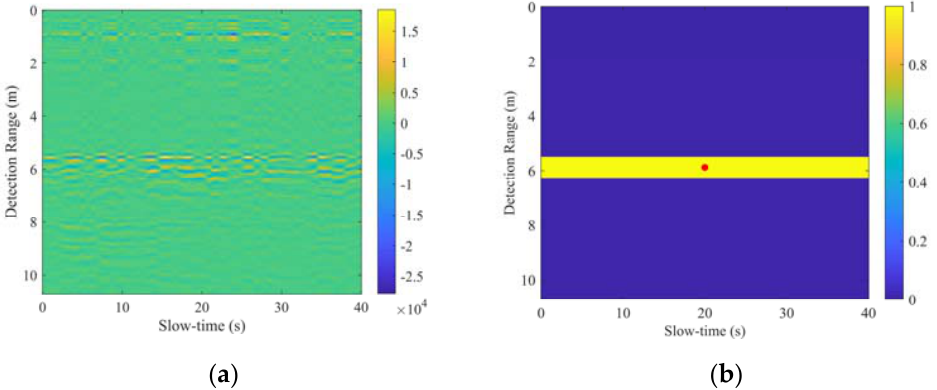
Figure 16. Results of Experiment 5.2: ( a ) range ‐ slow ‐ time matrix obtained after step A; ( b ) TPOIs extracted by CNN.